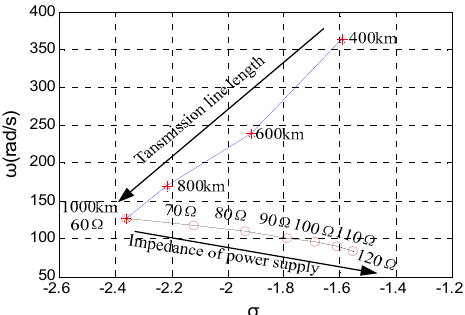
Figure 7. Variation trend of eigenvalues of the main electromagnetic oscillation mode with transmission line length and equivalent impedance of power supply (with no SVC).